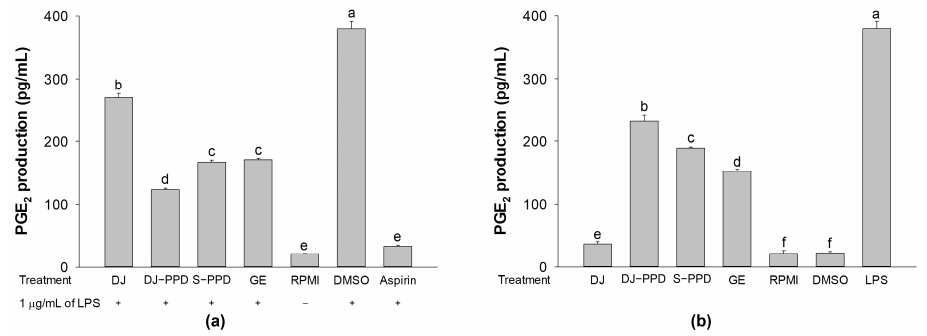
Figure 5. Regulation of PGE 2 production in cells pretreated with DJ extract, DJ-PPD extract, S-PPD, and GE extract. ( a ) The downregulation effect in LPS-stimulated RAW264.7 cells and ( b ) the upreg- ulation effect in unstimulated RAW264.7 cells. After the cells were stimulated with or without LPS, they were incubated for an additional 24 h. The supernatant from each treatment was collected, and the produced PGE 2 was measured. DJ, DJ-PPD, and GE concentrations were 100 µg/mL, whereas the S-PPD concentration was 700 pg/mL. DMSO, aspirin, and LPS concentrations were 0.1%, 200 µg/mL, and 1 µg/mL, respectively. Data are shown as means ± standard deviations. Different low- ercase letters indicate significant differences among treatments at p < 0.05.